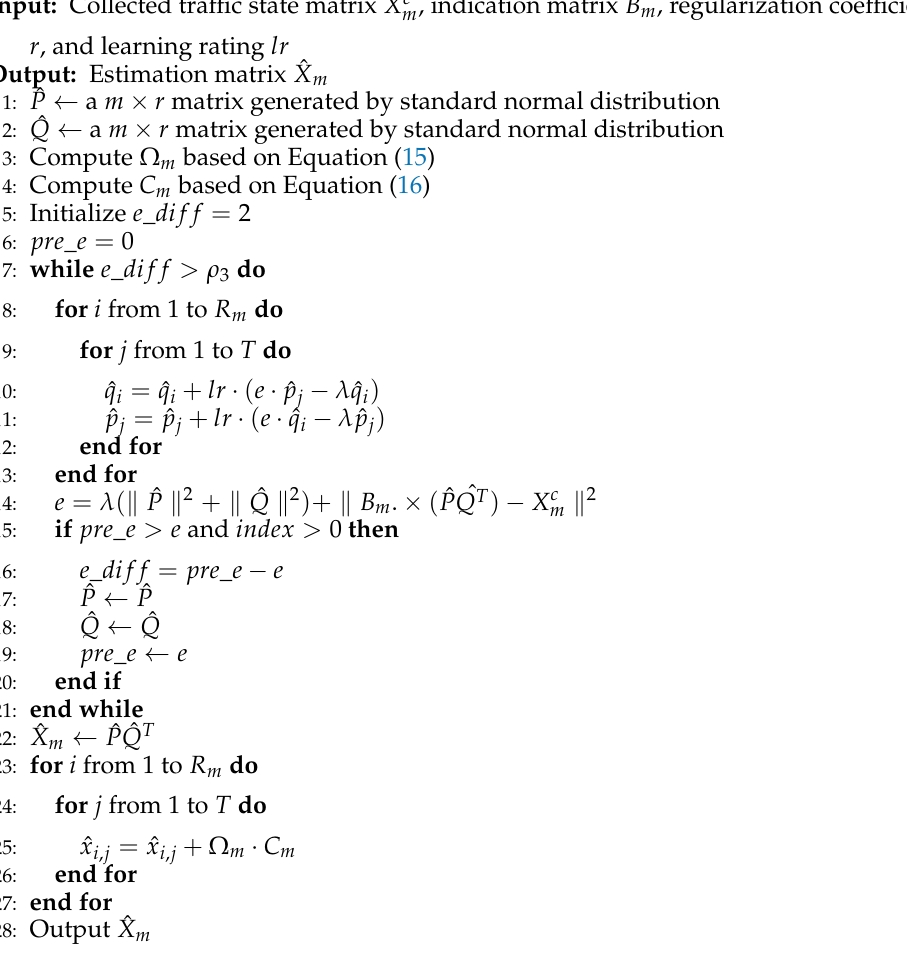
Algorithm 2 The Convex-based Data Recovery (CDR)